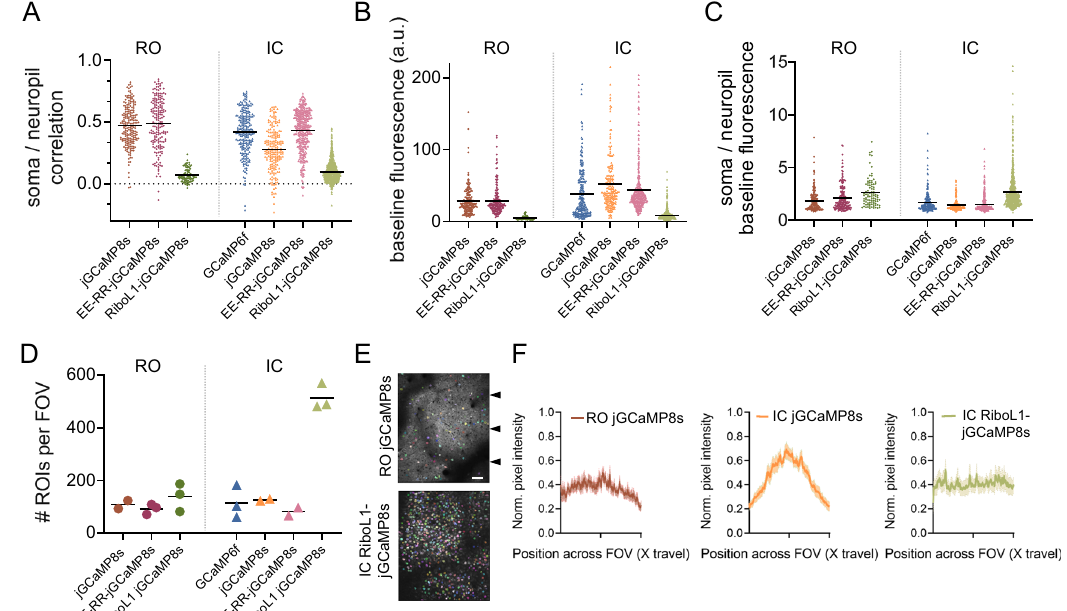
population mean. Scale bar indicates 50 µ m. E Examples of Cellpose segmentation mask (ROIs) for RO jGCaMP8s and IC RiboL1-jGCaMP8s. Arrows indicate the y positions of measurements used for F . F Normalized intensity pro fi les across the fi eld of view. Intensity was measured at three y positions and normalized to the highest pixel value. n =5, 4, and 4 mice. Lines indicate population mean, shaded area represents the SEM. Source data are available as a Source Data fi le.